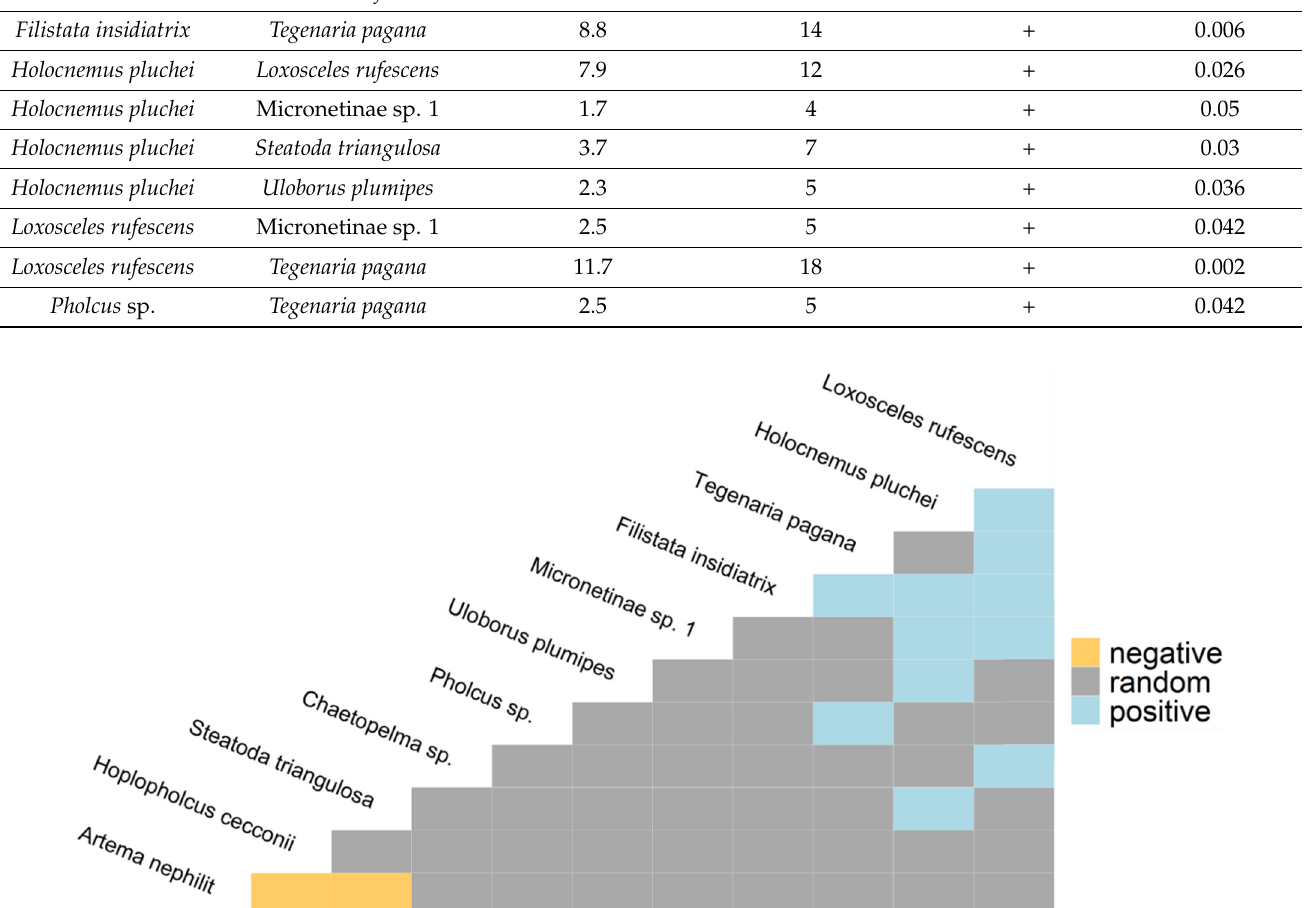
Figure 8. Species co-occurrence matrix for those species identified from cave spider assemblages from distinct cave zones. Yellow, grey, and blue points denote significantly negative, random, and significantly positive co-occurrences, respec- tively. Table 2. Species co-occurrence across cave zones. The probability corresponds to the probability that the respective species co-occur more, or less, than expected (listed as “relationship”, with “+” and “ − “ denoting positive and negative co-occur- rences, respectively). Negatively co-occurring species are in bold.